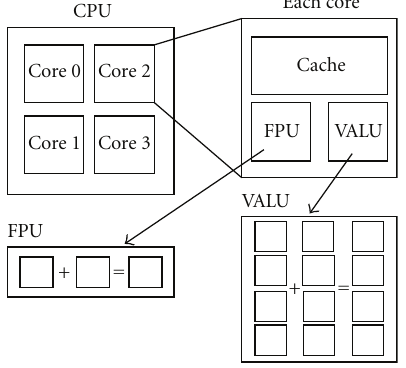
Figure 3: CPU architecture including FPU and